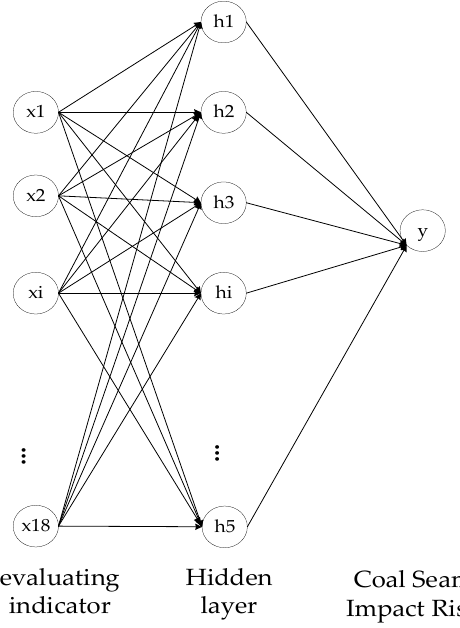
Figure 3. Propagation flow of BP neural network.